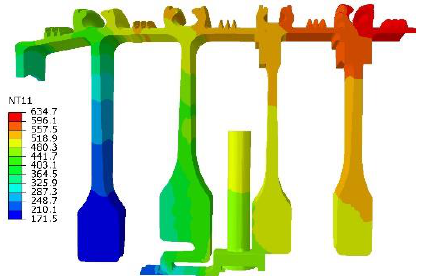
Figure 4. Temperature field (unit: °C, NT11 represents the node temperature).